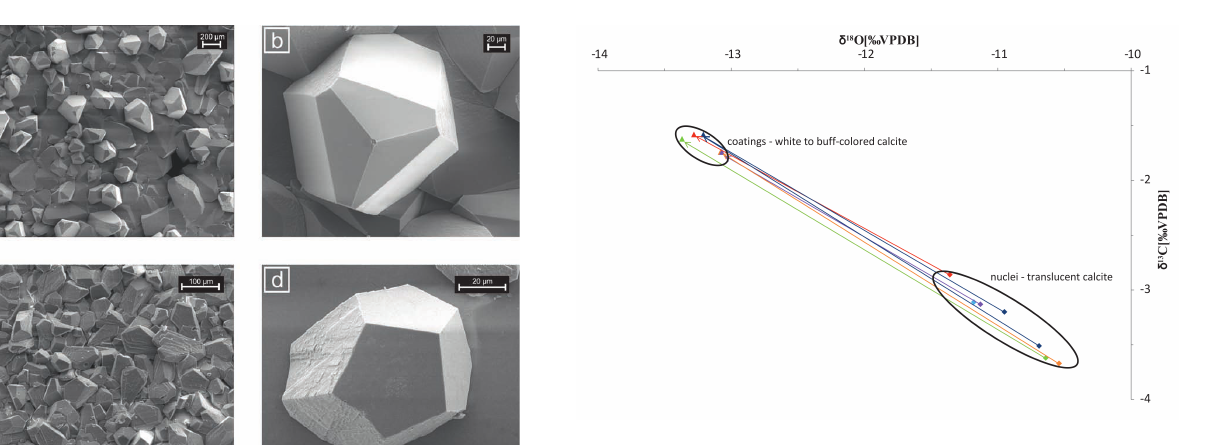
Fig. 8. Carbon and oxygen isotopic composition of selected zones of composite crystals with translucent nuclei and white to buff- colored